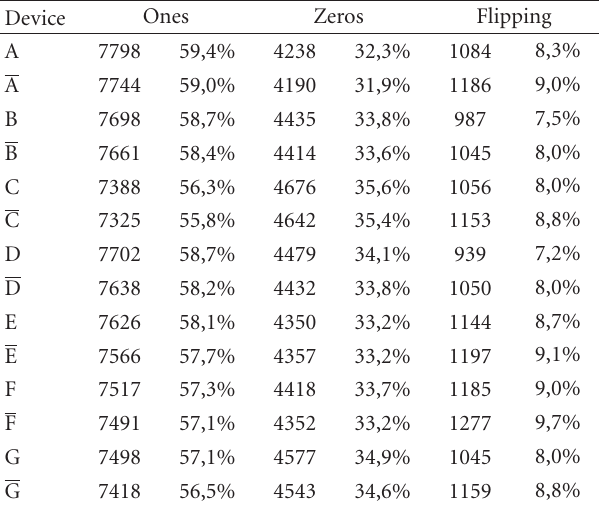
Table 2: Number of constant zeros, ones, and flipping bits.